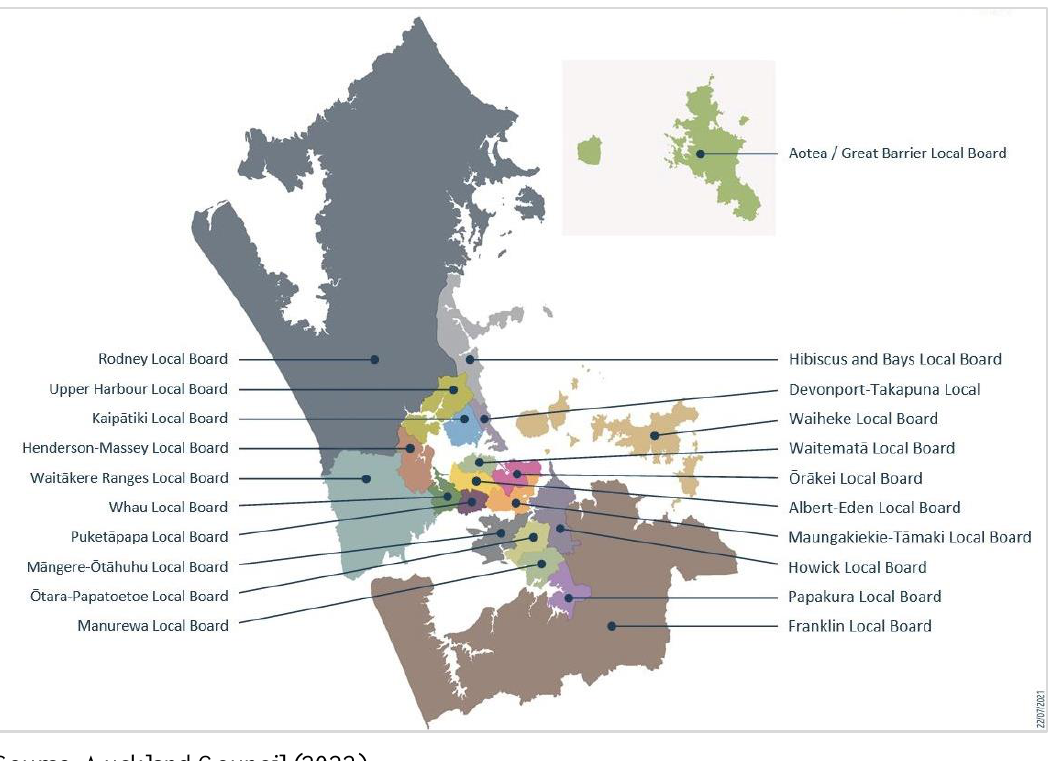
Figure 2: Auckland Council local board boundaries